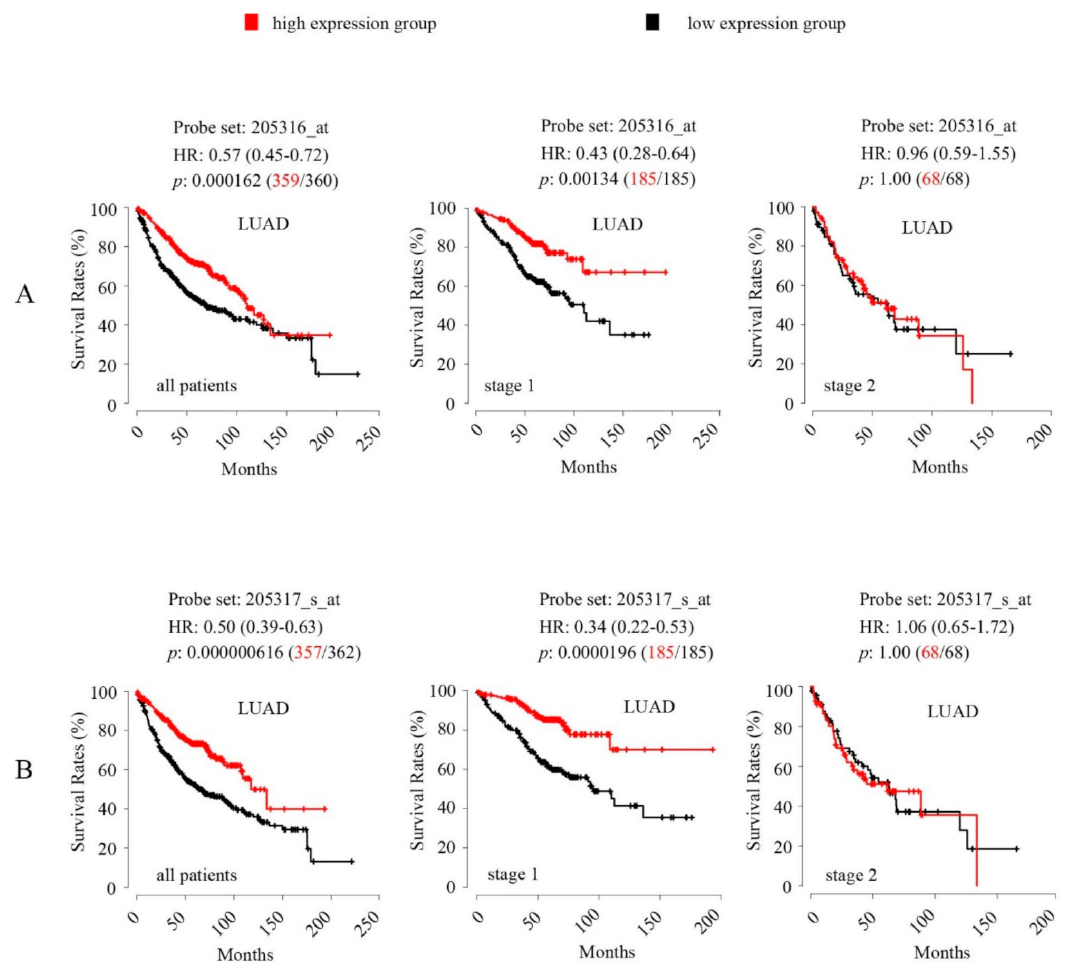
Figure 5. Kaplan-Meier survival analysis and Logrank test show significant associations of intratumoral SLC15A2 expression levels with overall survival rates in the lung cancer cohort from the Kaplan-Meier Plotter (KM-LUAD). Survival analysis was conducted using the expression data from the two SLC15A2 probe sets: 205316_at ( A ) and 205317_s_at ( B ). Patients were analysed altogether or following stratification by tumor histology. For analysis, the patients were separated using Median expression into high-expression group (Red curve) and low-expression group (Black curve). The number of patients in each group was given in bracket following the p -value. A Bonferroni-corrected cuto ff logrank p -value of < 0.05 indicates statistical significance. Hazard ratio (HR) and 95% confidence interval (CI) (bracket) are also